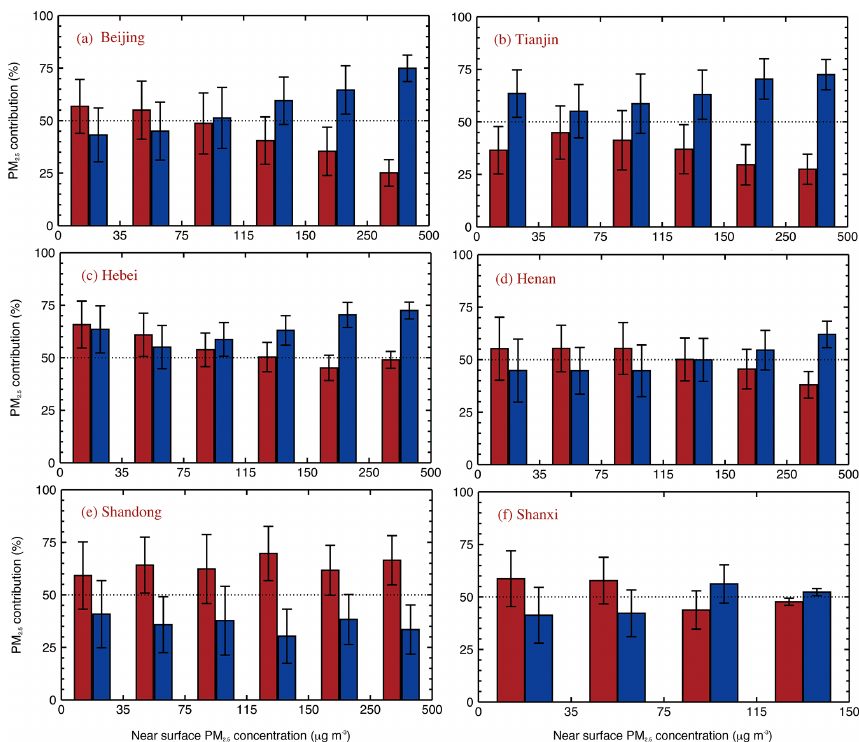
Figure 6. Average PM 2 . 5 contributions (%) in (a) Beijing, (b) Tianjin, (c) Hebei, (d) Henan, (e) Shandong, and (f) Shanxi from local (red) and nonlocal (blue) emissions from 5 December 2015 to 4 January 2016 under different pollution levels. Uncertainty is denoted by the error